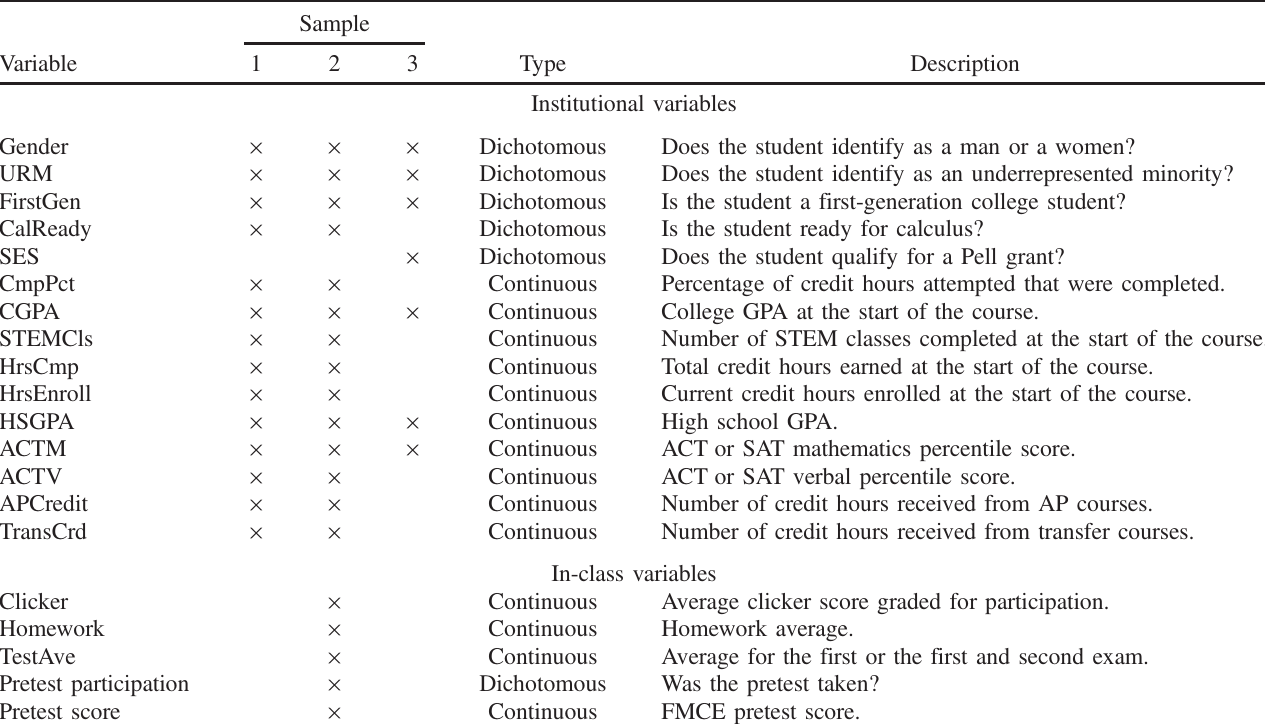
TABLE I. Full list of